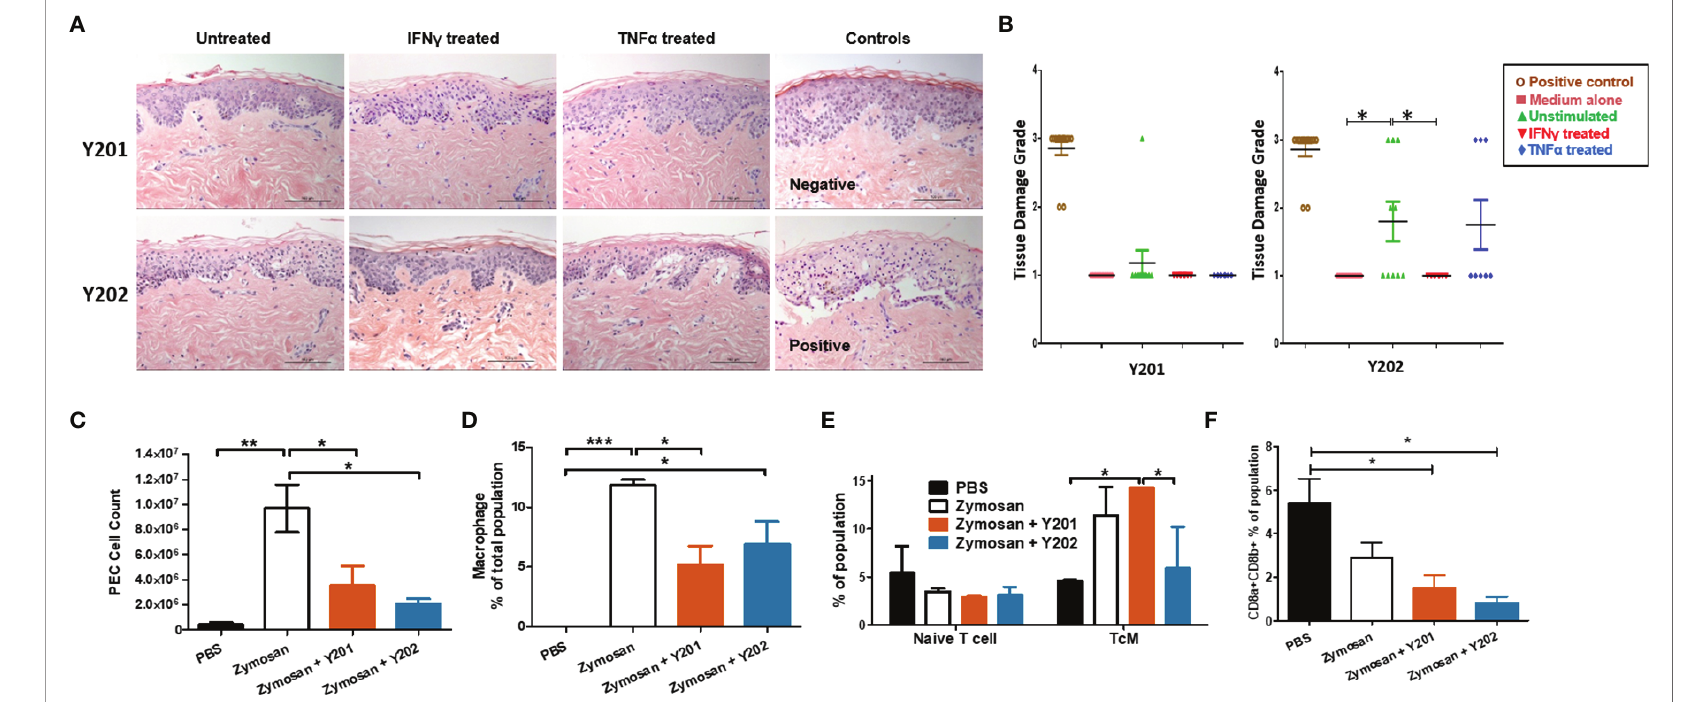
FIGURE 4 | In vitro and in vivo immunomodulation by CD317 neg Y201 or CD317 pos Y202 MSCs. (A) Representative images of skin explants independently assessed for damage to tissues, examining keratinocytes, basal cells, keratotic bodies, the appearance of sub-epidermal clefts at the junction with the dermis and in highly damaged tissue the appearance of complete epidermal separation following treatment with MSCs primed with IFN- g or TNF- a and co-cultured in vitro . (B) Y201 co-culture did not prompt damage to the tissue in any conditions whilst Y202 cell line demonstrated marked tissue damage in untreated cells and TNF- a treated cell lines. Both Y201 and Y202 cell lines retained the ability to inhibit tissue damage when primed with IFN- g . (C) MSCs subsequently applied to an in vivo peritonitis model of in fl ammation showed immunomodulation through reduced immune cell recruitment, (D) reduced macrophage development following Y201 treatment, (E) increased central memory T cell development following Y201 treatment and (F) reduced CD8+ cytotoxic T cell development following Y202 treatment. n=3, *p < 0.05, **p < 0.01, ***p <